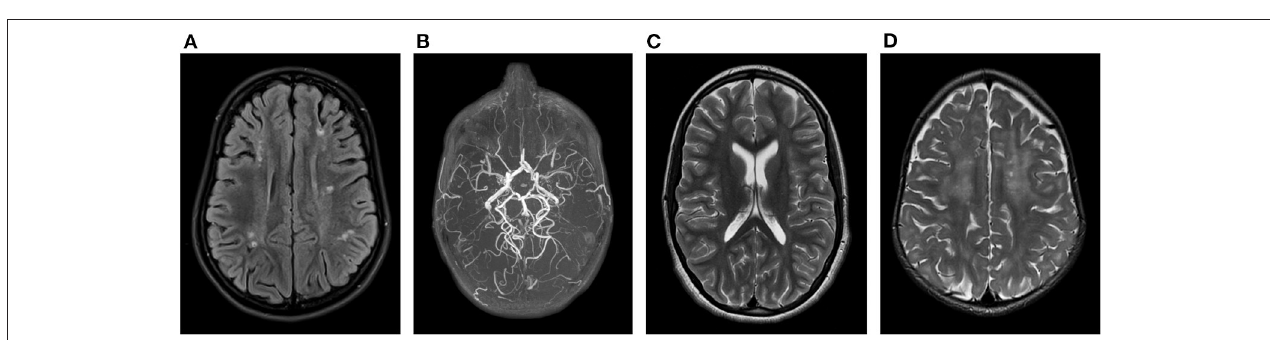
Frontiers in Neurology |